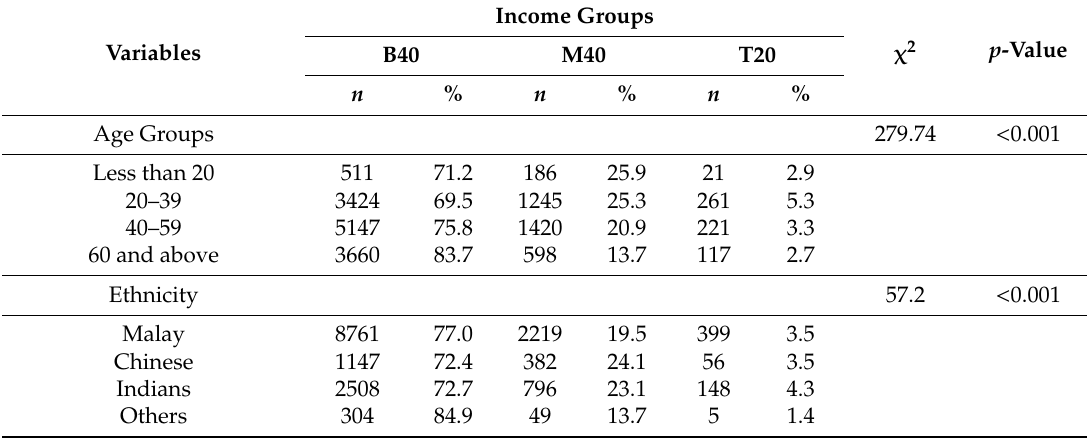
Table 2. Bivariate association between income groups and other predictor